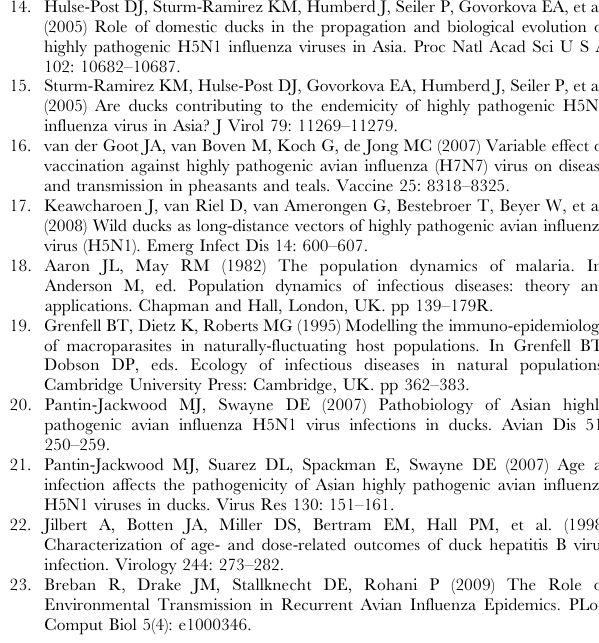
Figure S1 Estimated LP and HPAI infection rates. Proportion of young (black) and adult (grey) birds which become infectious by exposure to infected birds or a contaminated environment (top), or after inoculation with AI (bottom). Lines represent exponential curves for mean infection rates provided in Table 1. Marker size is proportional to the number of experimental challenges (1 to 70).